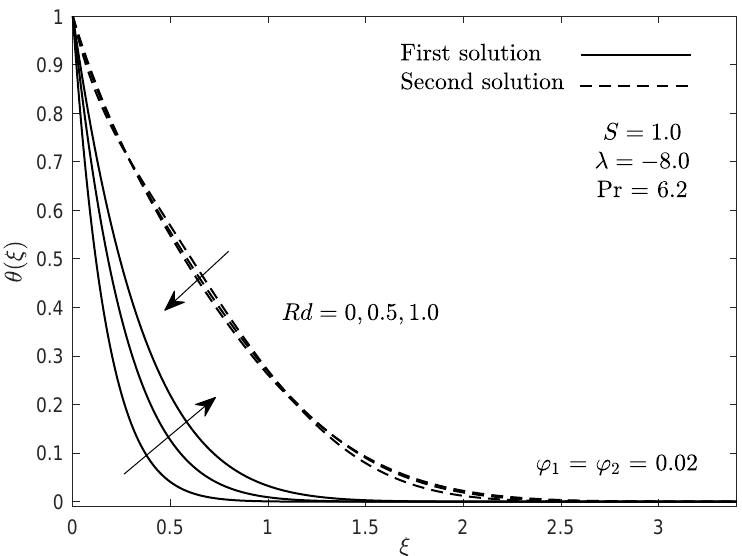
Figure 4. Impact of Rd on velocity distributions, f (cid:48) ( ξ ) .